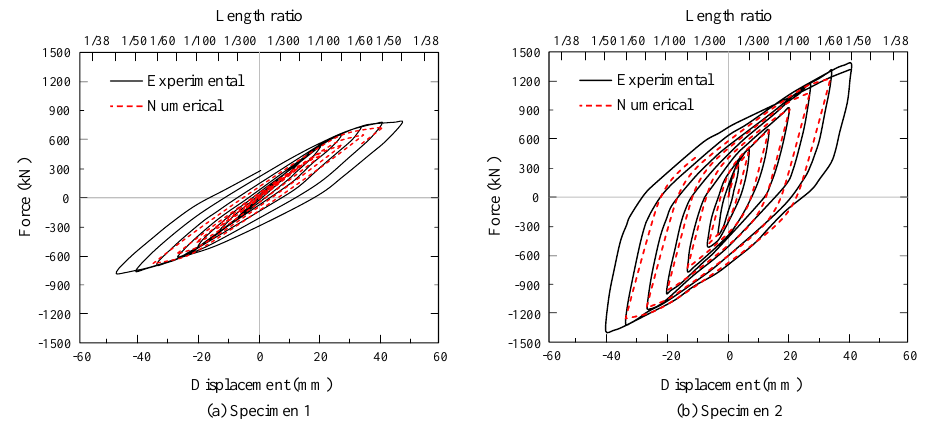
Figure 12. Comparison of hysteresis loops. Table 2. Basic parameters of concrete damage plastic model.